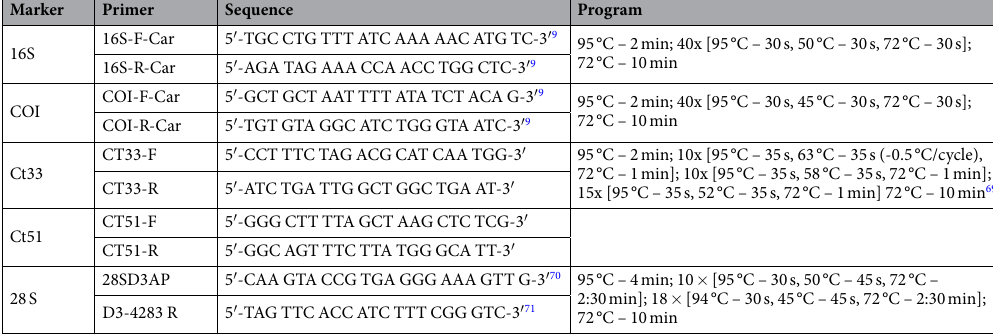
Table 3. Loci, primer sequences and PCR conditions utilised for C . typus